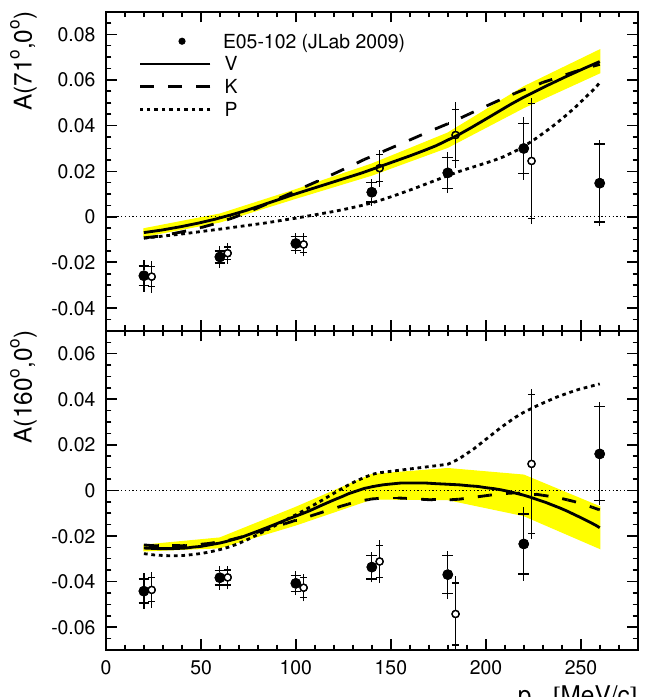
Figure 1: The measured asymmetries A ( 71 ◦ ,0 ◦ ) (top) and A ( 160 ◦ ,0 ◦ ) (bottom) in (cid:126) the quasi-elastic 3 He ( (cid:126) e,e (cid:48) d ) process as functions of missing momentum, compared to the acceptance-averaged V, K and P calculations (see text for notation). The empty symbols (shifted for clarity) denote the data with a cut on the quasi-elastic